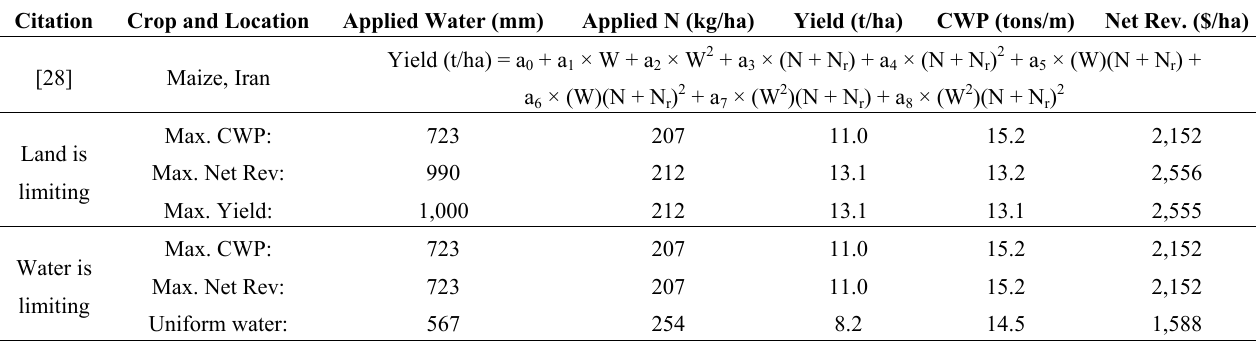
Table 2. Optimizing water and nitrogen applications for maize, when either land or water is the limiting